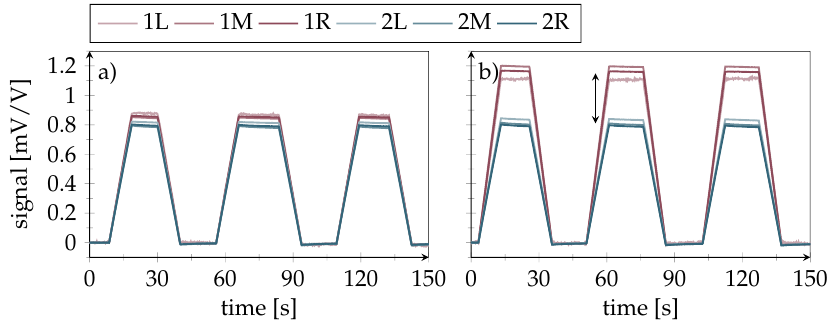
Figure 11. Sensor signals during cyclic quasi-static testing. ( a ) Artificial crack length of 16 mm; sensor Figure 14. Sensor signals during cyclic quasi-static testing at a) Artificial crack length: 16 signals between rows begin to deviate under load. ( b ) Artificial crack length of 23 mm; with increasing mm. Sensor signals between rows start to deviate under load. b) Artificial crack length: crack length, the signal amplitude of first row sensors rises. The colors indicate the first (red) and 23 mm. With increasing crack length, signal amplitude of first row sensors rises. Colors second (blue) sensor indicate first (red) and second sensor row (blue).